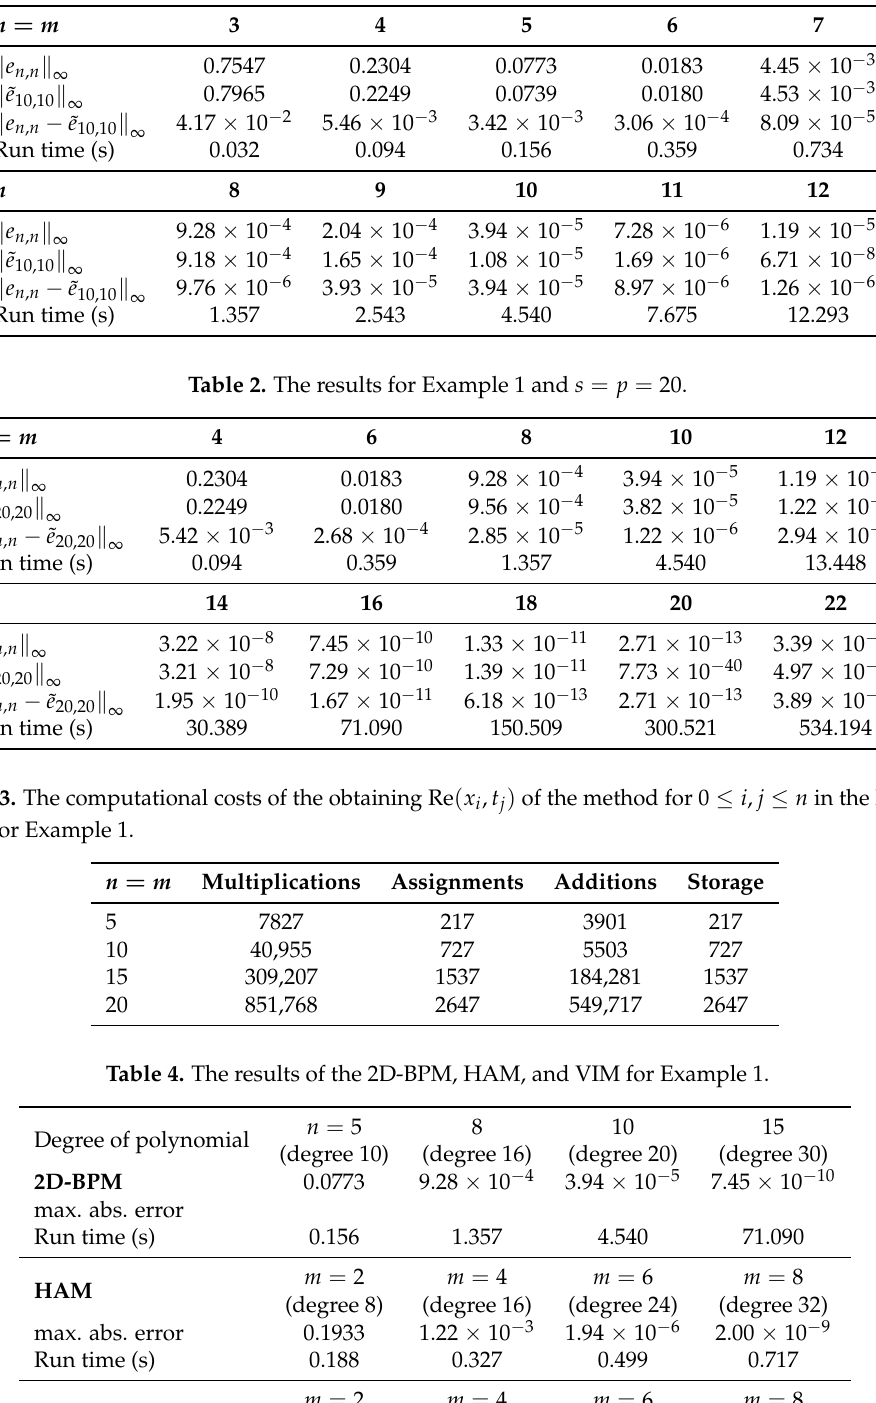
Table 1. The norms of absolute errors, the estimation of the errors by using the residual correction procedure, and the errors obtained by the corrected approximate solutions of Example 1 for s = p = 10.